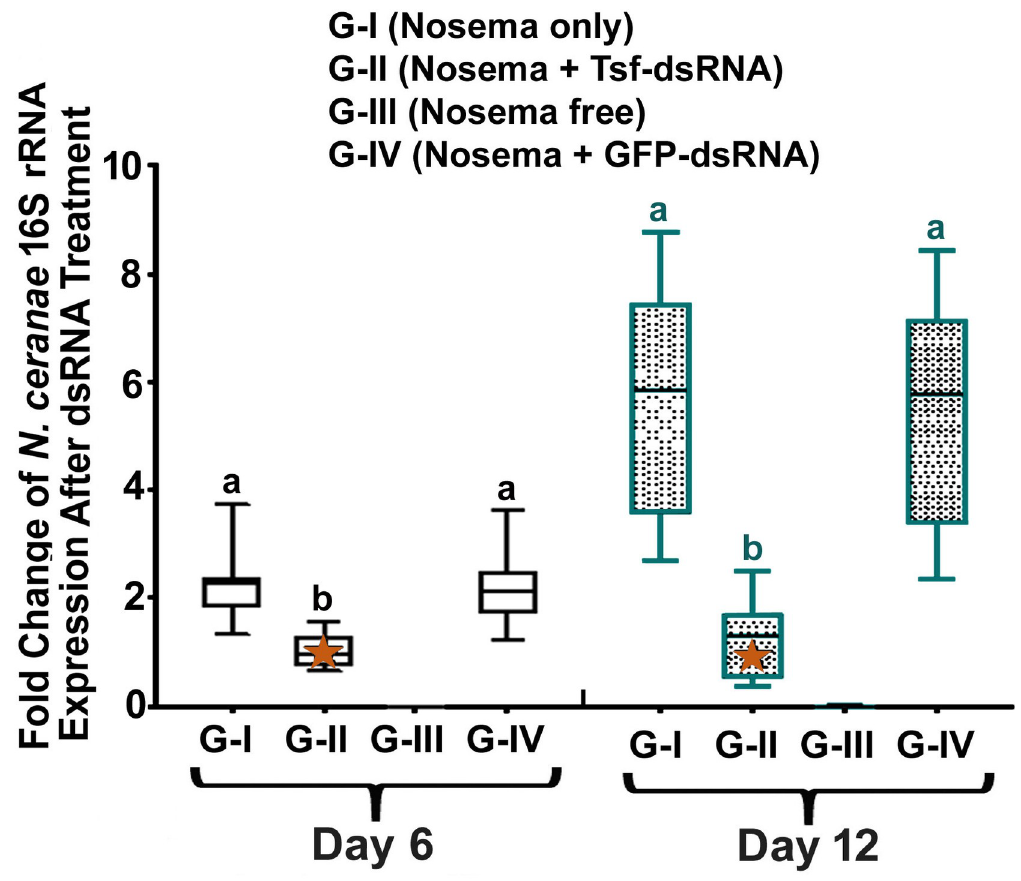
Fig 7. The relative expression of N . ceranae 16S rRNA after treatment of AmTsf -dsRNA. The relative expression was expressed as an n-fold difference relative to the calibrator (marked by a star) by 2 – ΔΔ Ct method. A star denotes a calibrator and the different lower-case letters above bars indicate the statistically significant difference among different groups ( P � 0.05, ANOVA and Tukey´s tests).